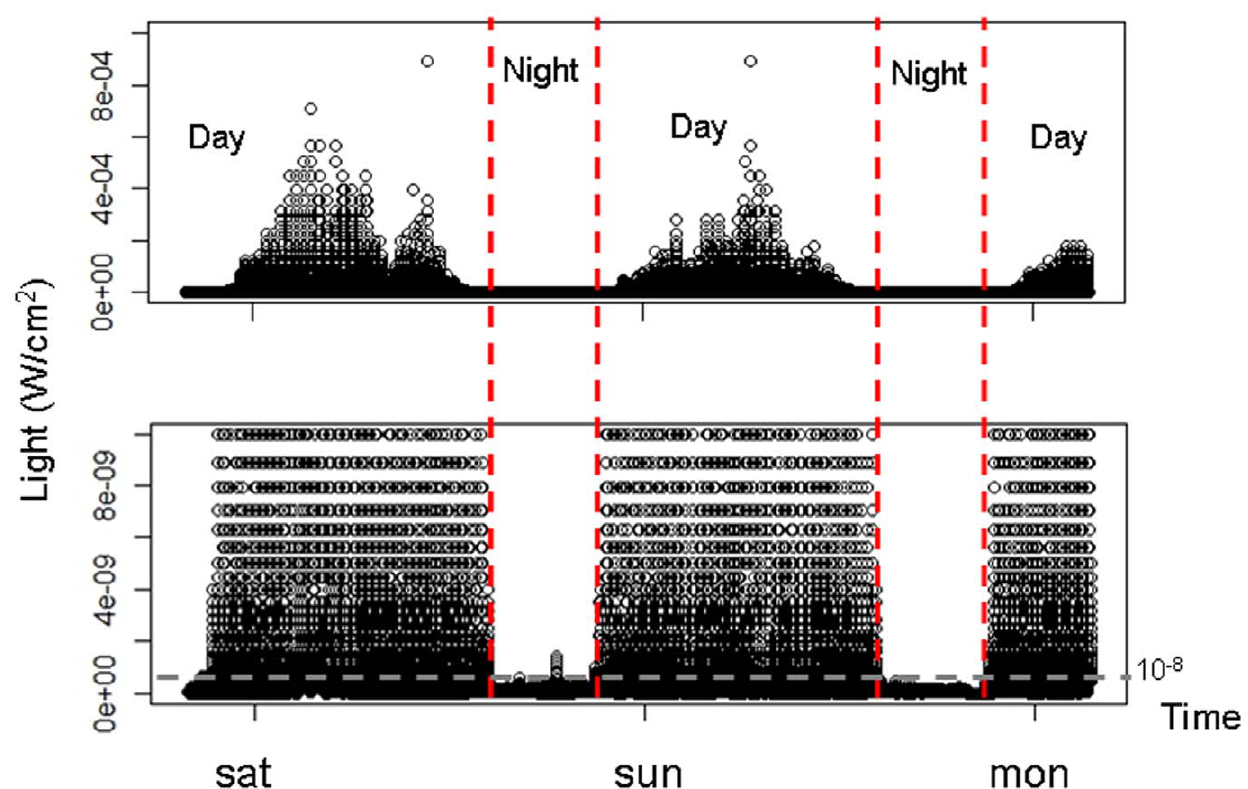
Figure 2. Separating of day and night periods. These graphs show light profile during 2 complete days and the beginning to a third. The dotted grey line represents the day and night separation threshold. For a dive, if the surface light is higher than this threshold (10 2 8 W.cm 2 2 ), the dive is considered as a day dive and if the surface light is lower than this threshold, the dive is considered as night dive. The dotted red vertical lines represent the separation between day and night